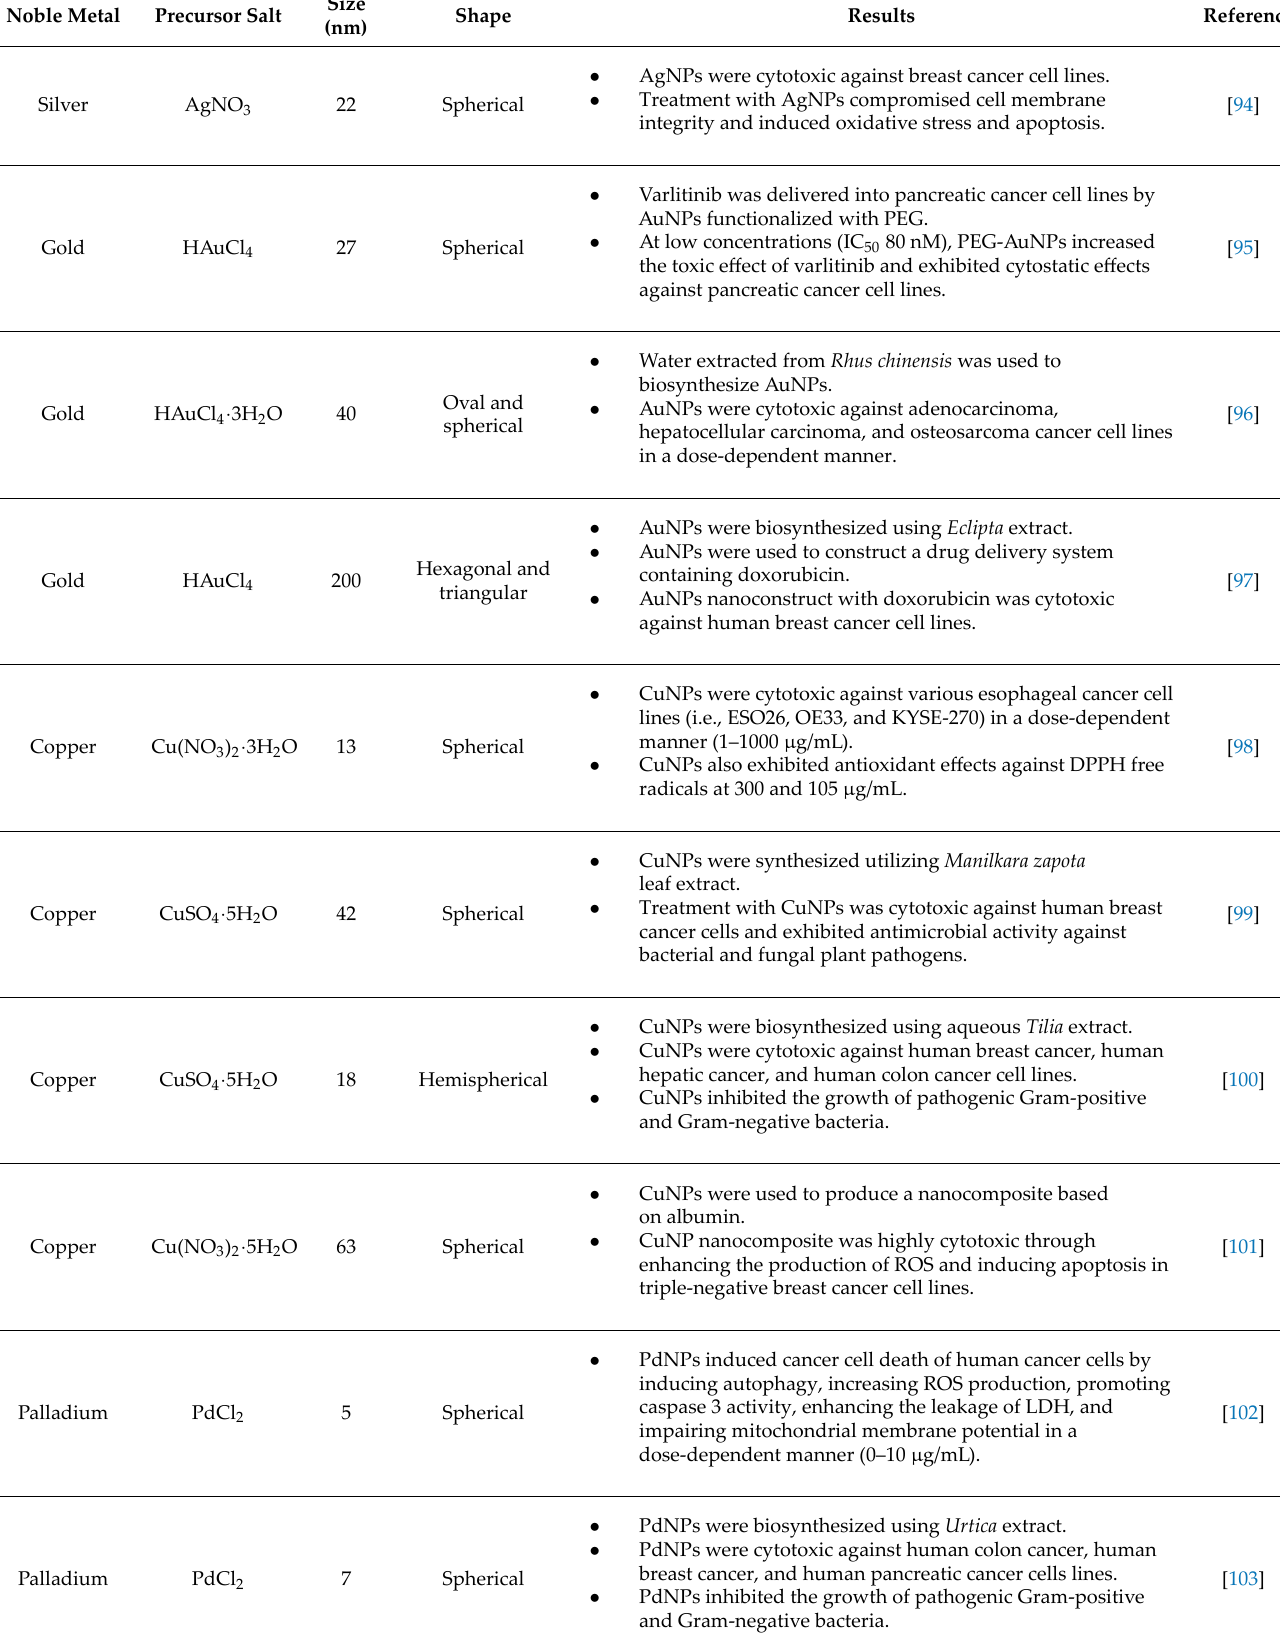
against pancreatic cancer cell